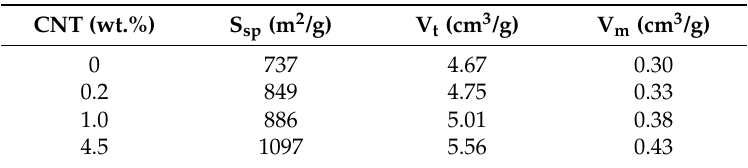
Table 1. Properties of silica–CNT hybrid aerogel microparticles (S sp is specific surface area, V t is specific pore volume, and V m is specific mesopore